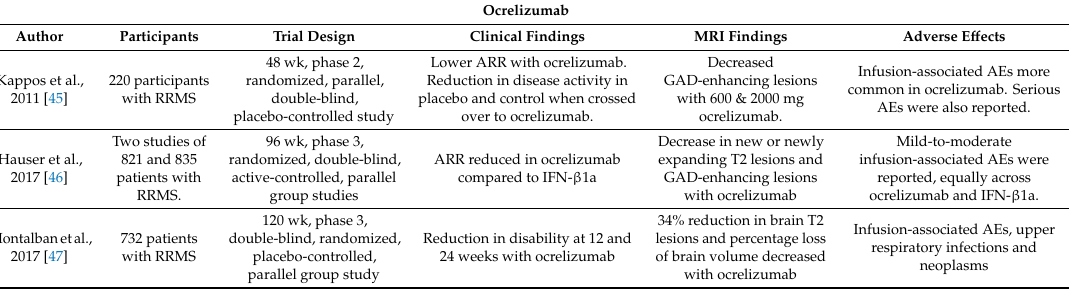
Table 2. A Summary of Clinical Trials Using